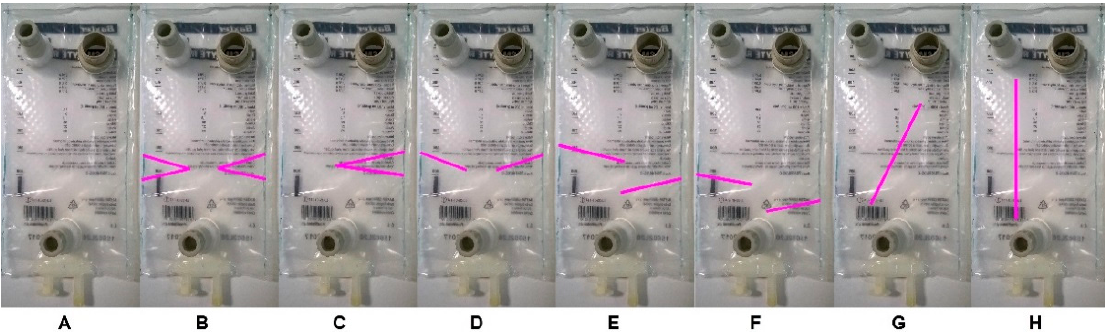
Figure 2. Compartment designs. The intravenous bags were constricted at specific positions by welding, as highlighted by magenta lines. Letters denominate the individual compartment types ( A – H ).